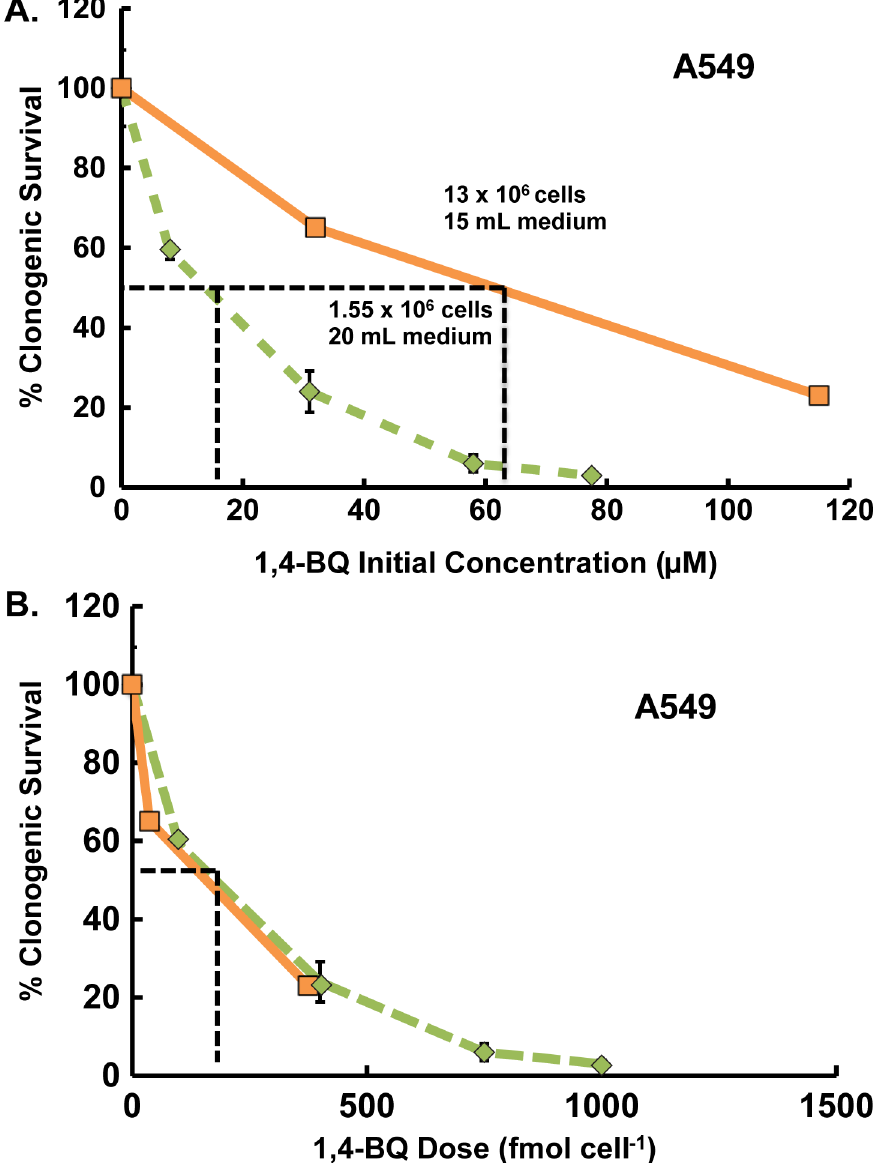
Fig 1. Dose of 1,4-BQ expressed as mol cell -1 allows direct comparisons between different experimental conditions and more accurately reports toxicity than initial concentration in medium. Clonogenic survival of A549 cells was observed after a 4-h exposure to 1,4-BQ using two different experimental conditions: orange square, 13 x 10 6 cells exposed in 15.0 mL of medium; green diamond, 1.55 x 10 6 cells exposed in 20.0 mL medium. The doses are expressed in: (A) Initial concentration in medium ( μ M), note that EC 50 depends on the physical setup of the experiment; (B) Mol cell -1 basis (here fmol cell -1 ); note that ED 50 is independent of the physical setup of the experiment. The two clonogenic survival curves are representative experiments with each point being the median of six plates. Error bars represent the standard error of the median; many error bars are smaller than the